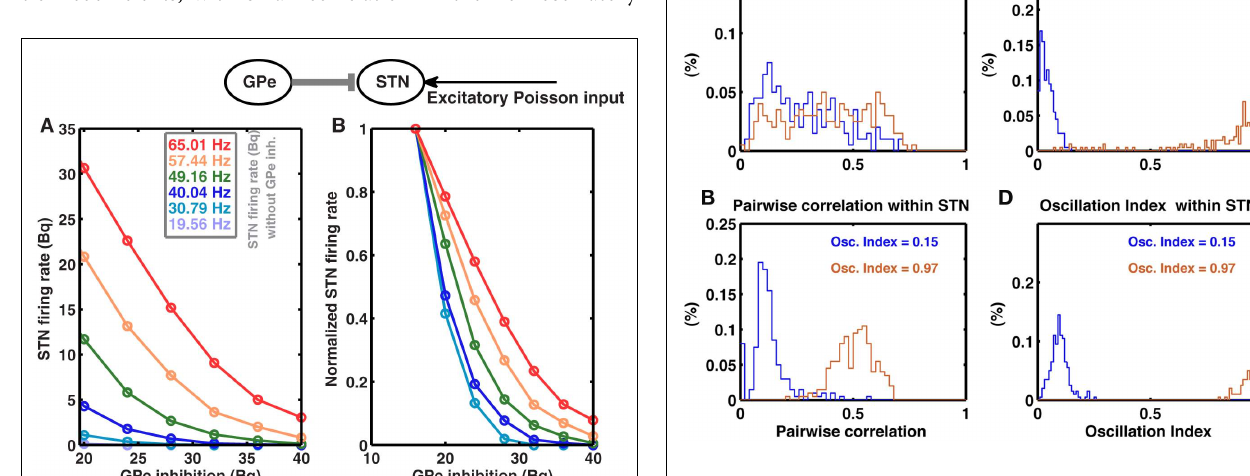
FIGURE 4 | Pairwise correlations in the STN and GPe populations. (A) Histogram of pairwise correlations estimated from 100 unique pairs of GPe neuron in a non-oscillating (blue trace) and a oscillating state (brown trace). (B) Same as in (A) , but for 1000 unique pairs of STN neurons. Oscillation induce stronger synchrony (correlations) in the STN than GPe. (C) Oscillation index of the cross-correlogram of GPe neuron pairs. In a non-oscillatory state the OI corr is small (blue trace). In an oscillatory state despite of global oscillations some neuron pairs do not show oscillations in their cross-correlogram (brown trace). (D) Same as in (C) . Unlike GPe network, STN more neuron pairs show oscillations in their cross-correlogram (brown